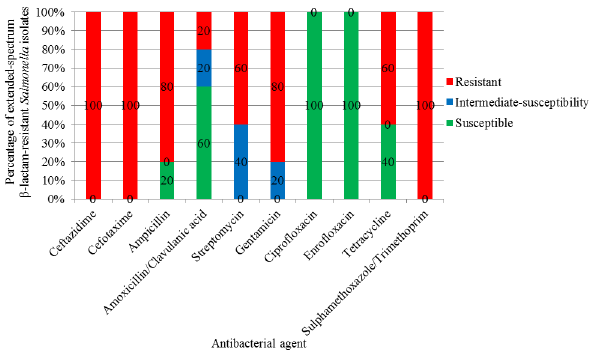
Fig. 5. Resistance of extended-spectrum